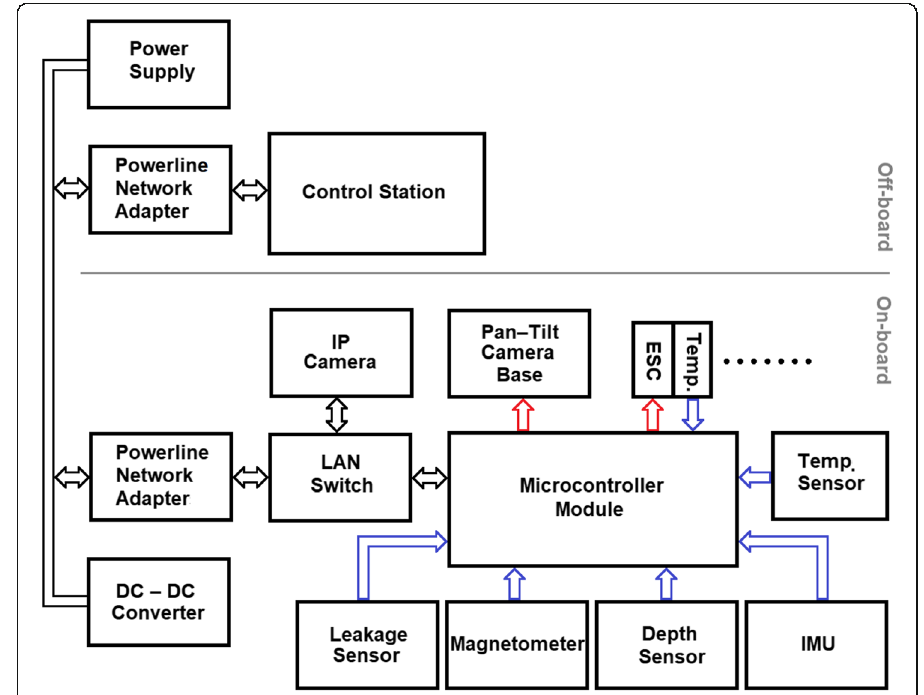
Fig. 4 Spaiser ’ s circuit block